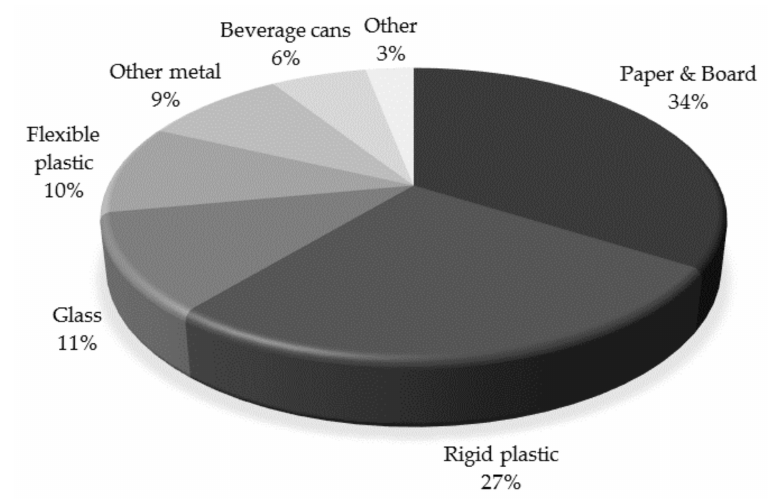
Figure 1. Market share of food packaging materials. Adapted from [2], with permission from